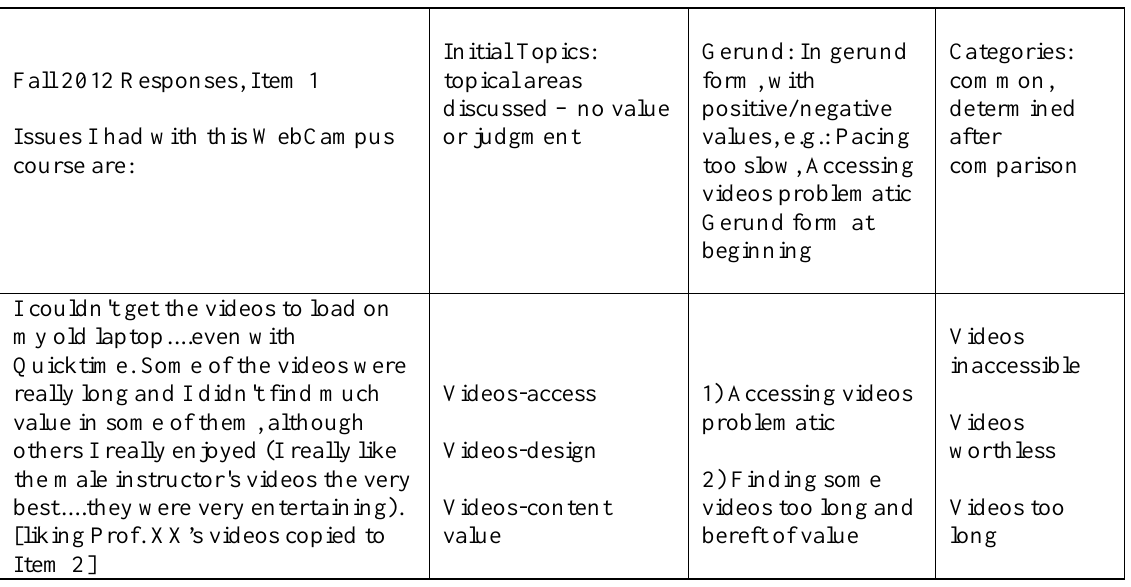
Figure 3 . Response table and categorization of the